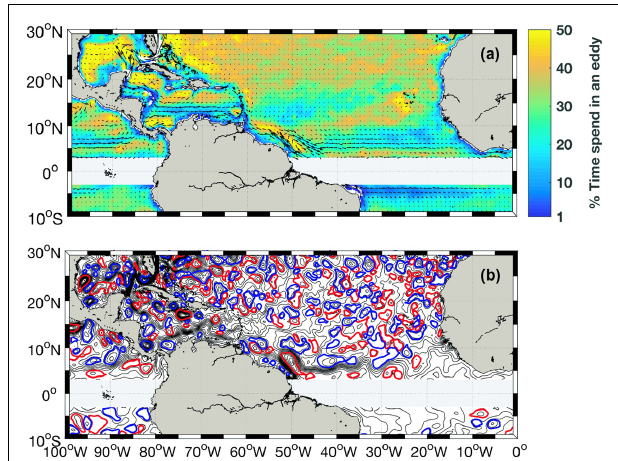
FIGURE 8 | (a) Shading shows the percentage of time each 1 ◦ × 1 ◦ box is within an eddy, based on the eddy detection algorithm of Laxenaire et al. (2019). Vectors represent the annual mean surface currents from Aviso Ssalto/Duacs and distributed by the Copernicus Marine Environment Monitoring Service (http://marine.copernicus.eu/) in the version released in April 2014 (Duacs/Aviso+, 2014; Pujol et al., 2016). (b) Absolute Dynamic Topography (ADT) field from Aviso Ssalto/Duacs, based on satellite altimetry on July 1, 2017, showing a well-defined North Brazil Current retroflection and North Equatorial Countercurrent in the western tropical North Atlantic. ADT is plotted every 2.5 cm. Red and blue contours indicate the maximum geostrophic velocities of anticyclonic and cyclonic eddies,